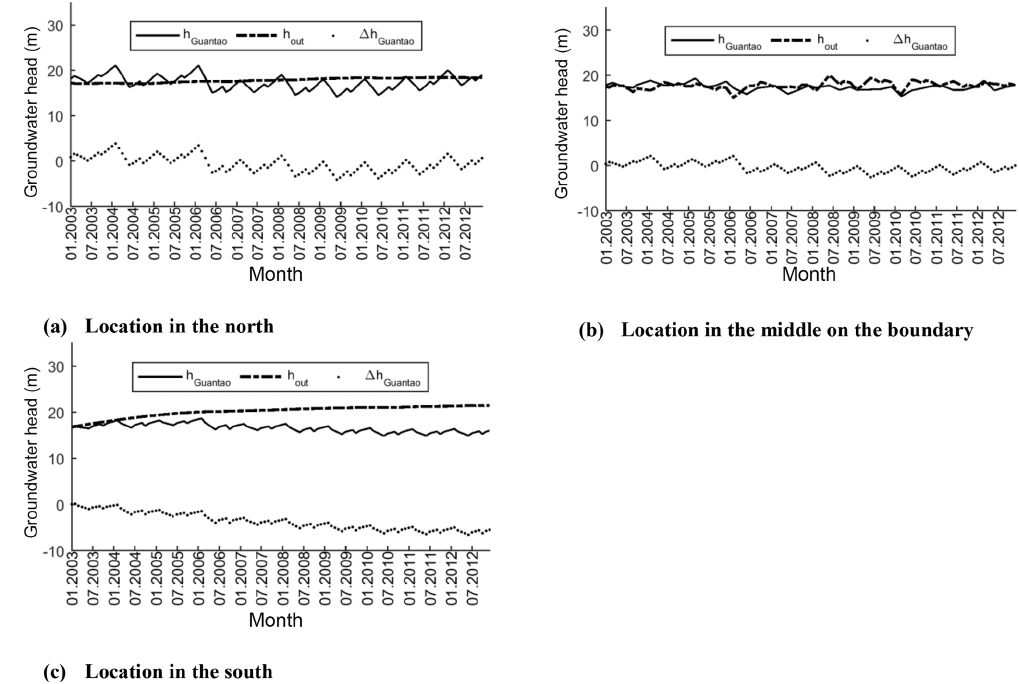
Figure 11. Time series of groundwater heads in Guantao at three selected locations and their decomposition.